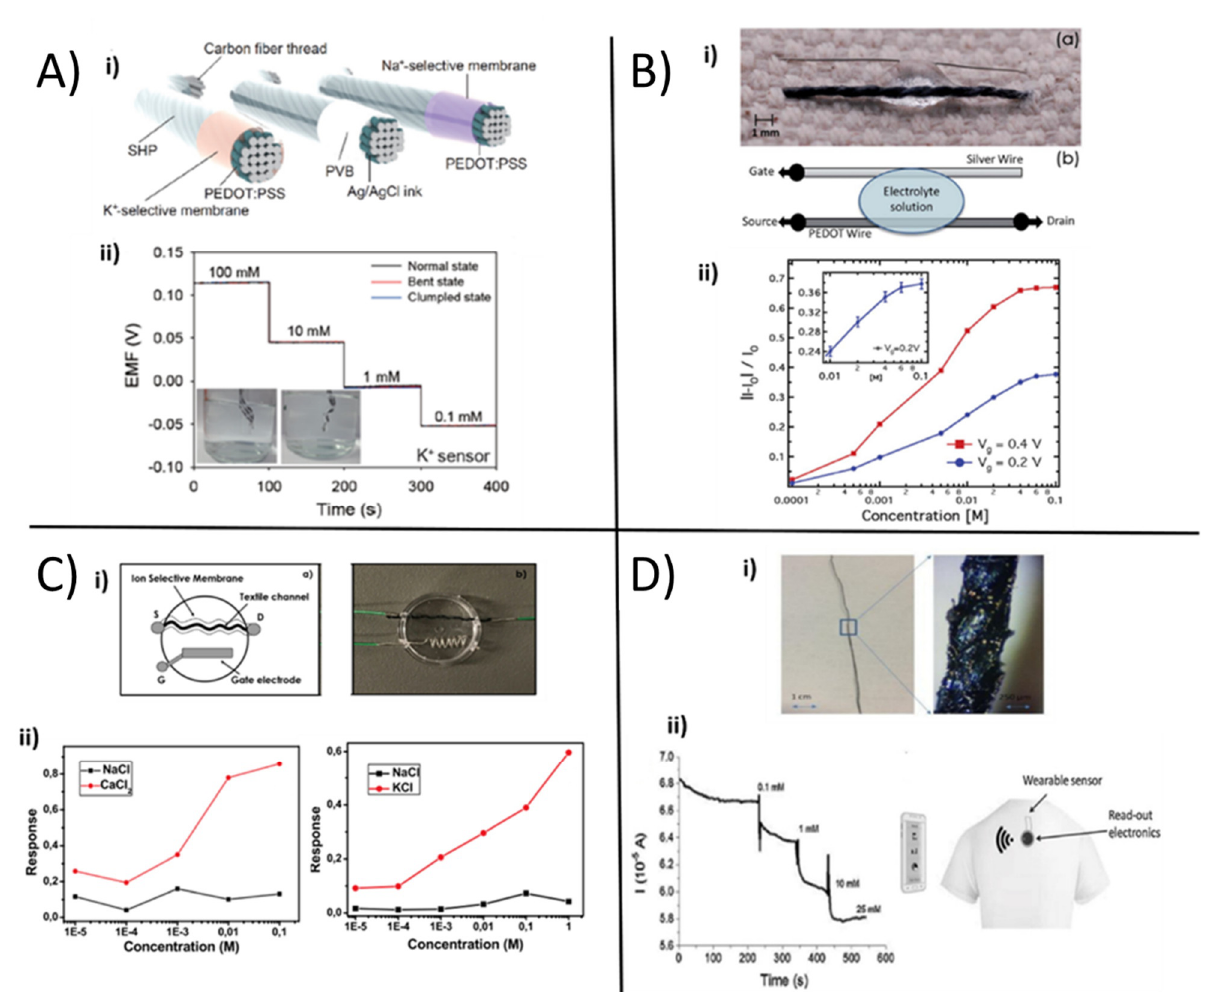
Figure 5. ( A ) i. Schematic illustration of self-healing ion-sensing and reference thread electrodes; ii. electrochemical characterization of sweat K + sensor (adapted with permission from [91] Copyright (2021) American Chemical Society; ( B ) i. OECT based on a single cotton thread integrated on fabric. The bottom thread is the PEDOT wire channel while the upper wire is the Ag gate electrode; ii. plot of the normalized OECT response recorded at different gate voltages as a function of the salt concentration (reproduced from [92] with permission from the Royal Society of Chemistry). ( C ) i. textile ion selective OECT sketch with the ion selective membrane around textile channel and Ag gate electrode, ii. responses of textile -OECT as function of CaCl 2 , Na and KCl at gate voltage of 1V (adapted from [93] with permission from Elsevier); ( D ) i. optical microscopy images of a cotton thread modified with the PEDOT:PSS/Ag/AgCl NPs composite material; ii. textile SP/NP-based sensor response while Cl − concentration was increased (reproduced from [94] with permission from Elsevier). PVB: polyvinyl